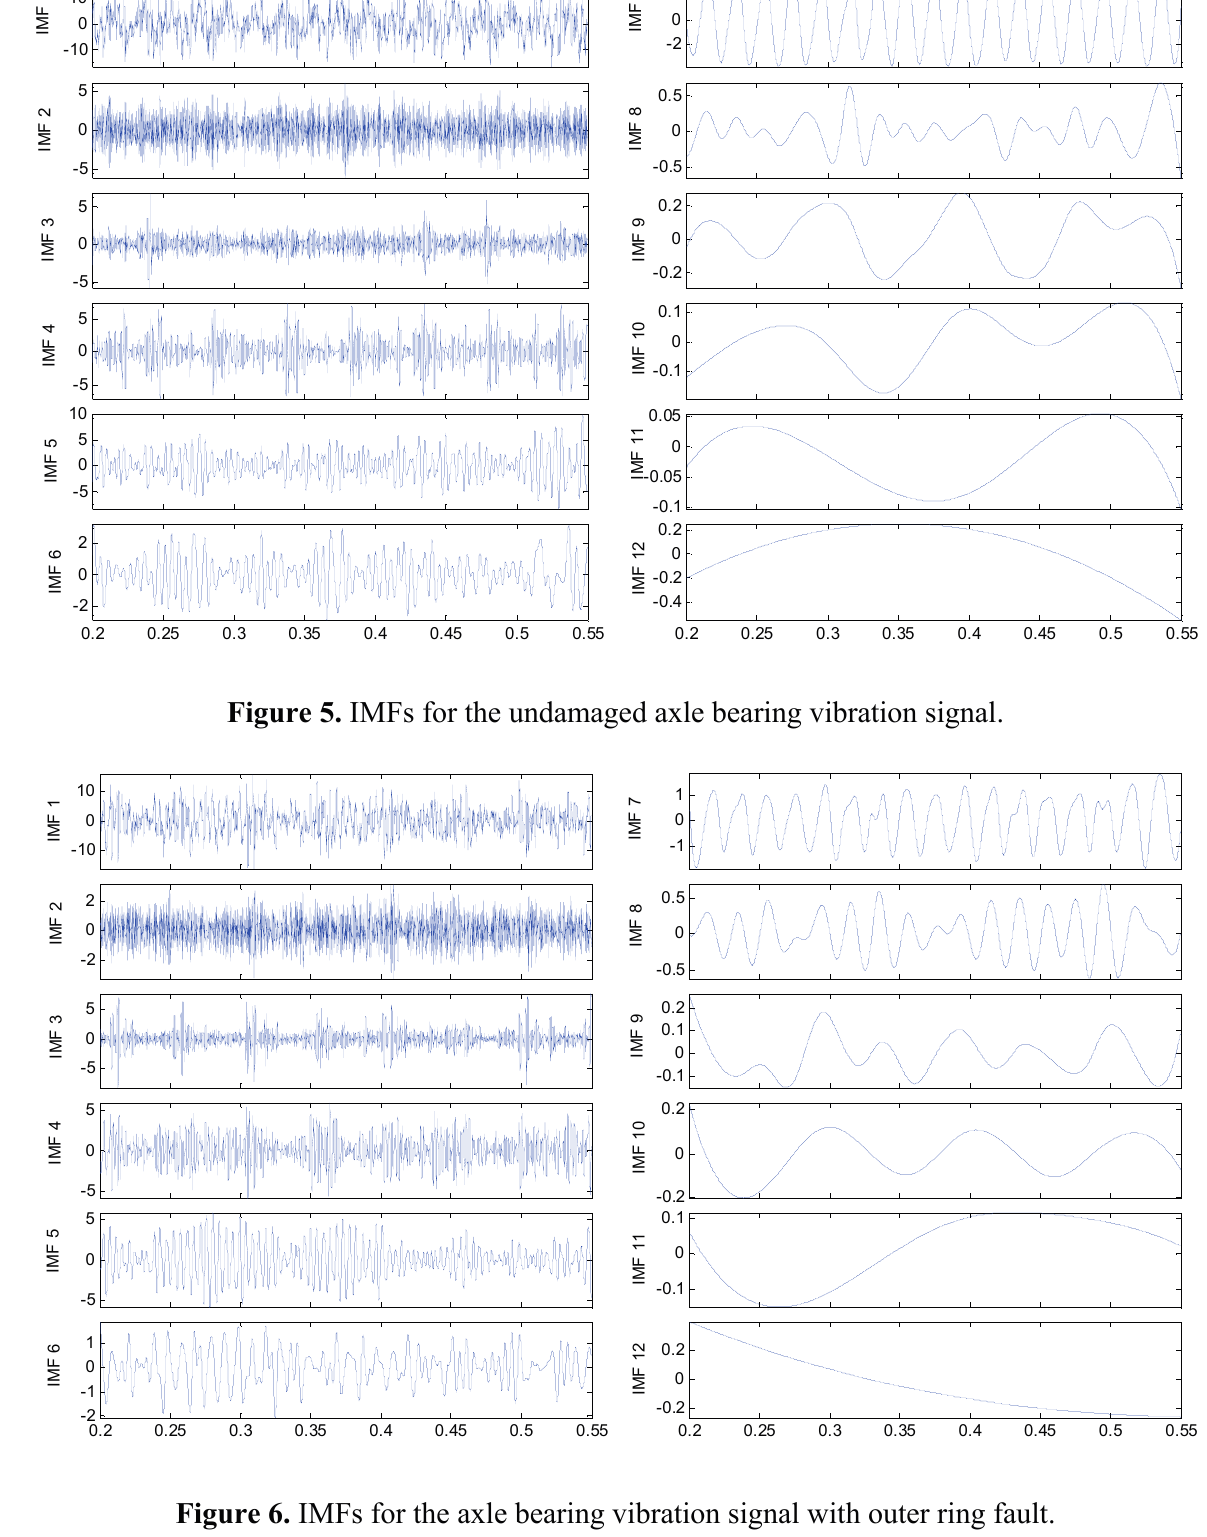
Figure 6. IMFs for the axle bearing vibration signal with outer ring